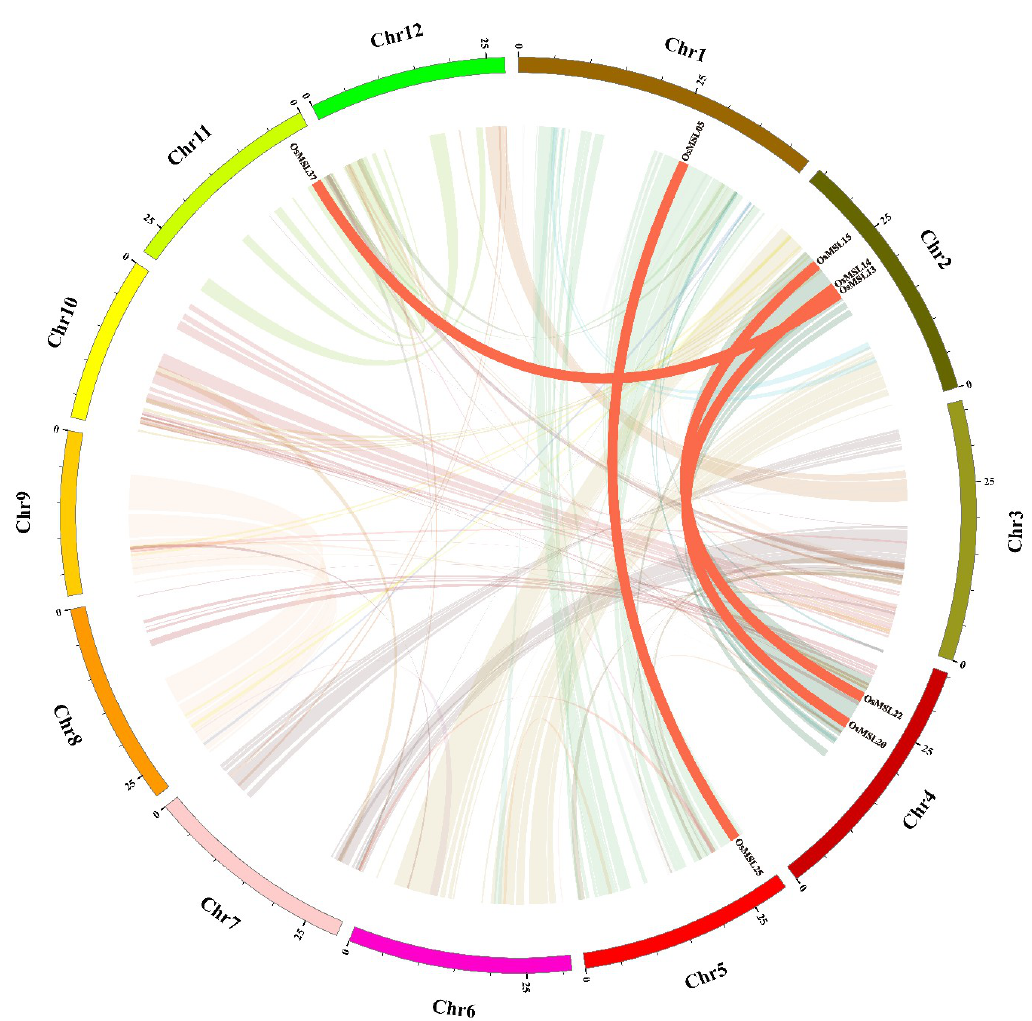
Figure 2. Schematic representations of segmental duplications of rice trihelix genes. Different color lines indicate all synteny blocks in rice genome between each chromosome, and the thick red lines indicate duplicated trihelix gene pairs. The chromosome number is indicated at the bottom of each chromosome. Scale bar marked on the chromosome indicating chromosome lengths (Mb).